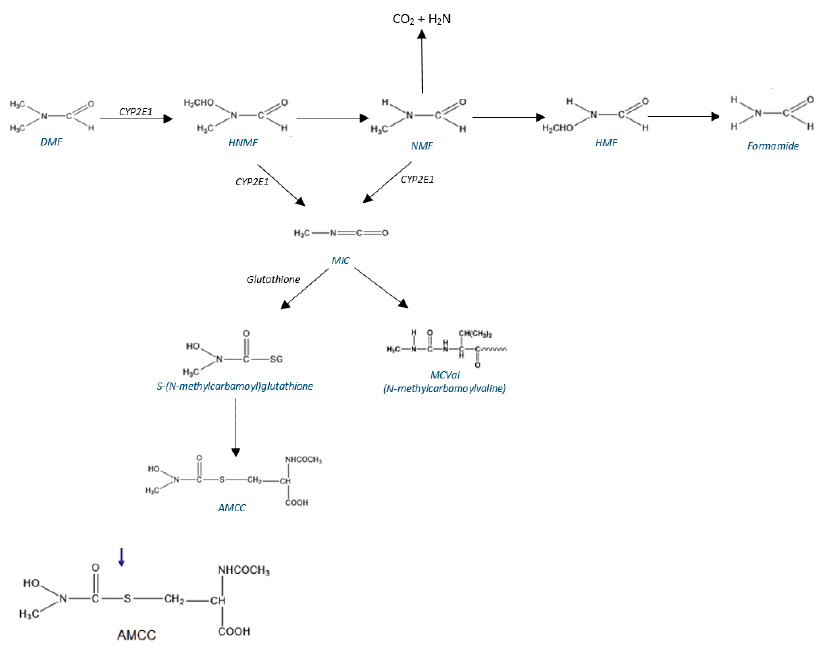
Figure 2. A scheme for the metabolic pathways of DMF (as described in the